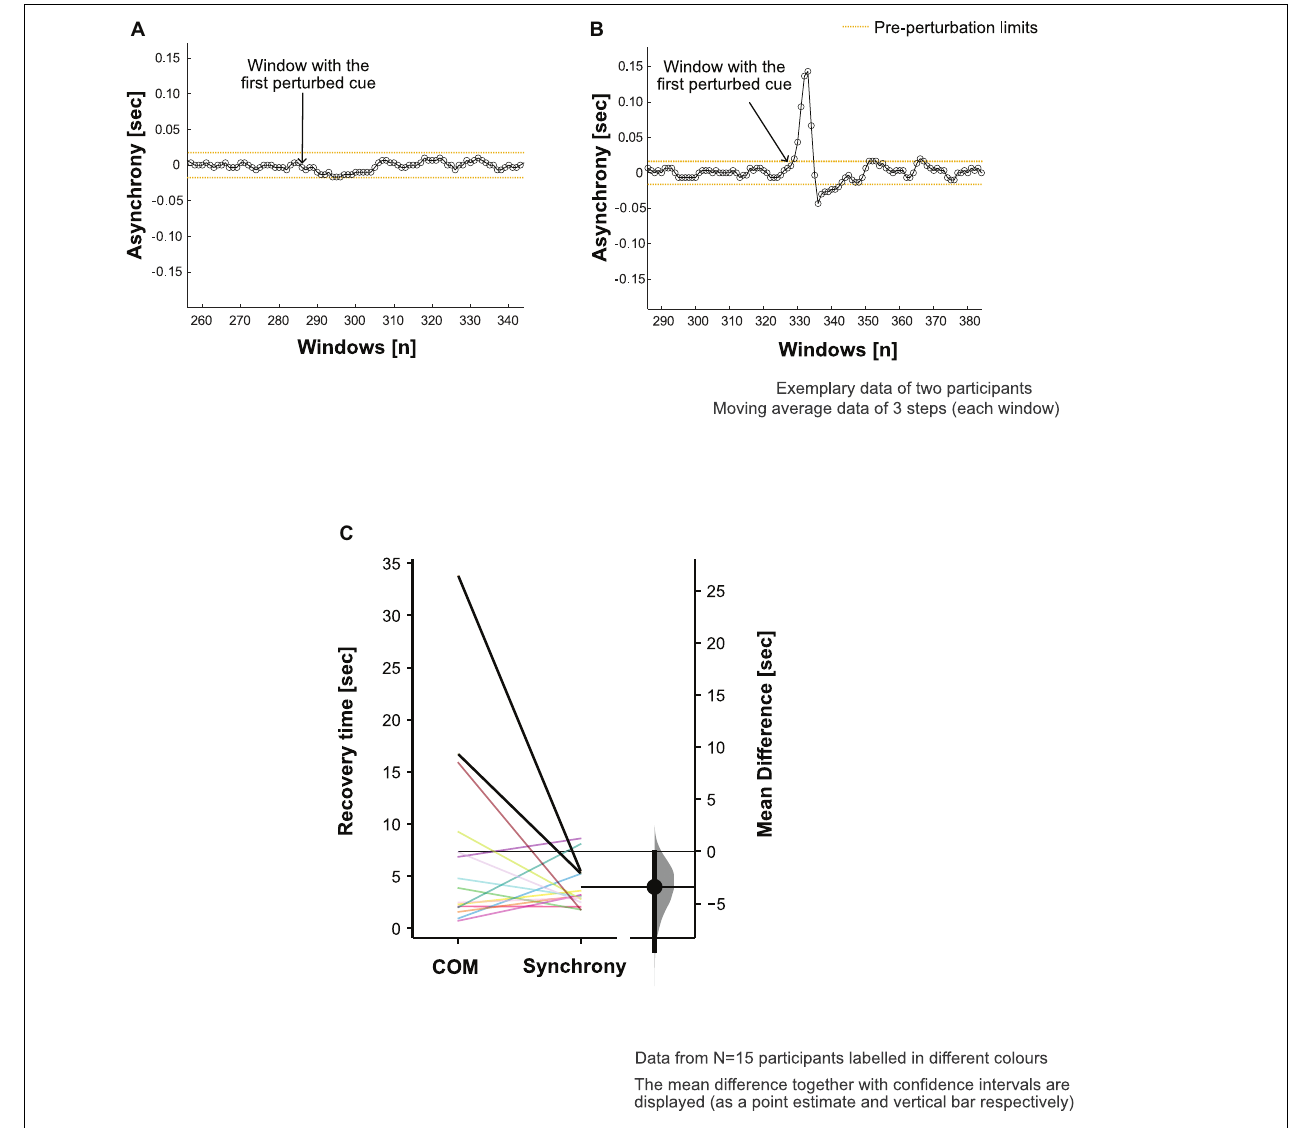
FIGURE 3 | Footfall asynchrony characteristics. Adjustment of step time to align the footsteps with perturbed cues (i.e., synchronization) was achieved in 18 out of 20 participants. Exemplary data are presented to demonstrate the asynchrony (refer to section “Recovery of Footfall Synchrony to Pre-perturbation Limits” in the manuscript for calculation details) characteristics in panel (A) a participant who did not adjust their step time to achieve the alignment of the footsteps with the perturbed cues and (B) a participant who did synchronize to the perturbed auditory cues. (C) Comparison of center of mass (COM) and synchrony recovery times in all the participants who showed deviation from steady state patterns in response to the auditory perturbation ( N =